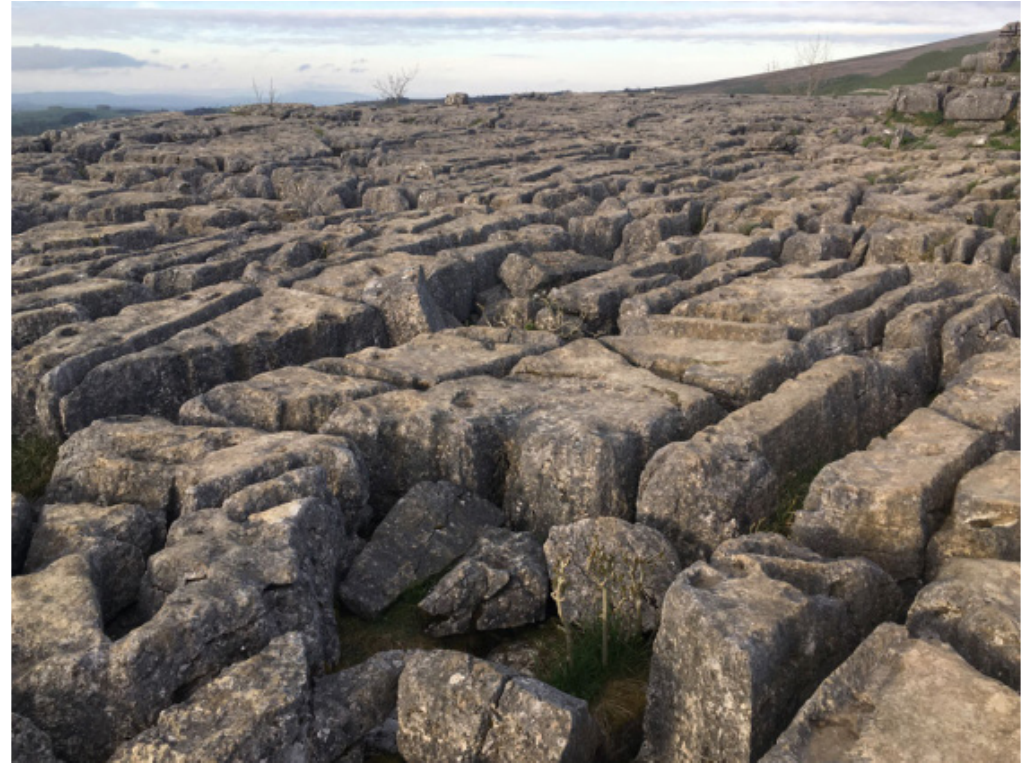
Figure 1. The iconic pavement at the top of Malham Cove in the Yorkshire Dales National Park. The limestone is heavily polished from the passage of many